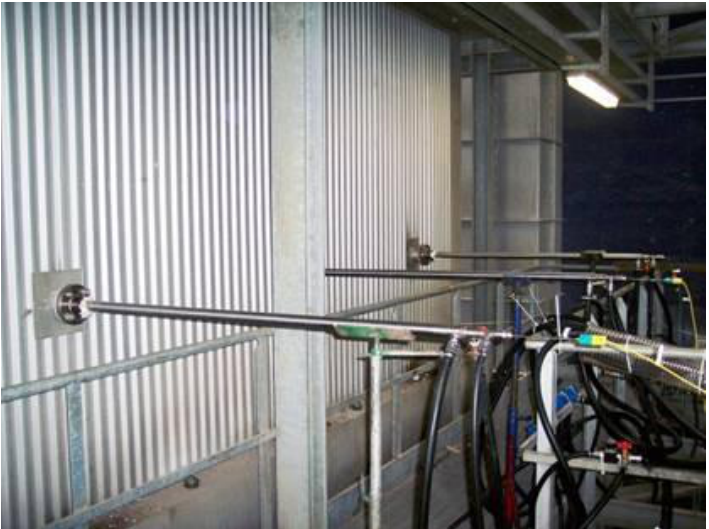
Figure 7. Three suction pyrometers are used to estimate the temperature profile in the post combustion zone of a WTE boiler.